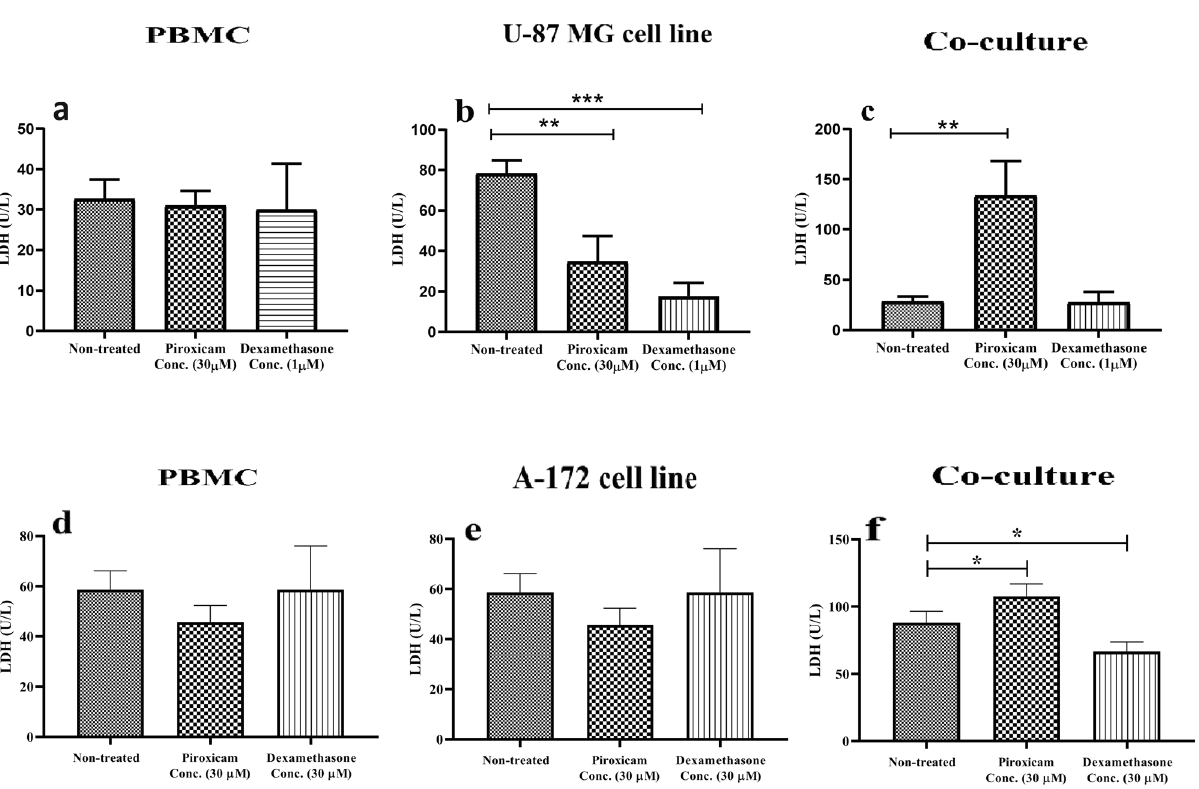
Figure 7. The effect of drugs on the LDH activity of T cells in PBMCs alone or in co-culture condition. The effect of dexamethasone and piroxicam on the LDH activity was compared in PBMCs cells alone ( a, d ), U-87 MG cell line ( b ), A-172 cell line ( e ), and in the co-culture condition ( c, f ) (n = 3). The graphs show the mean ± SD. Significant changes are indicated with asterisk (* p < 0.05, ** p < 0.01, *** p < 0.001, **** p <